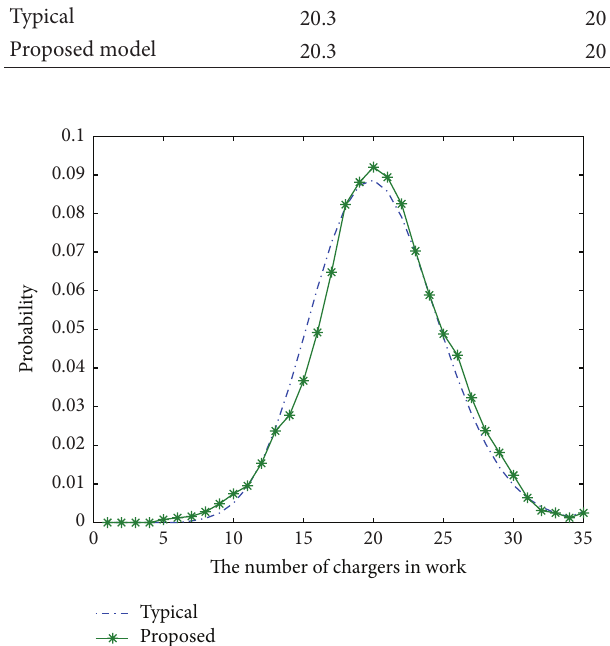
Figure 8: The comparison of probability distribution of EV charger in work using typical and proposed model.